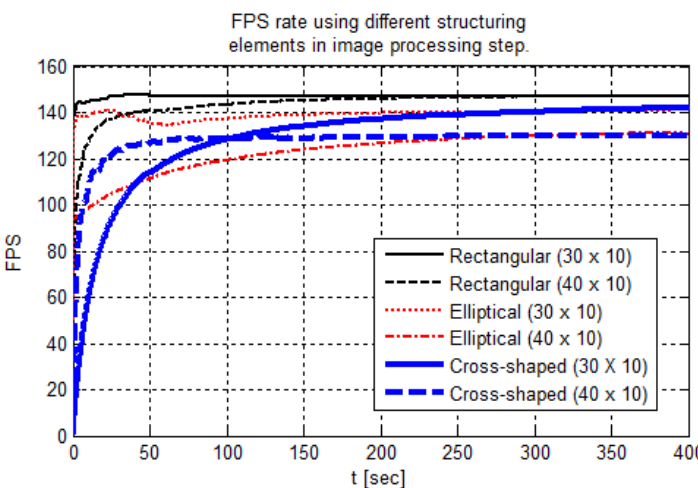
Figure 23. Frames per second rate for different kernel shapes and sizes.